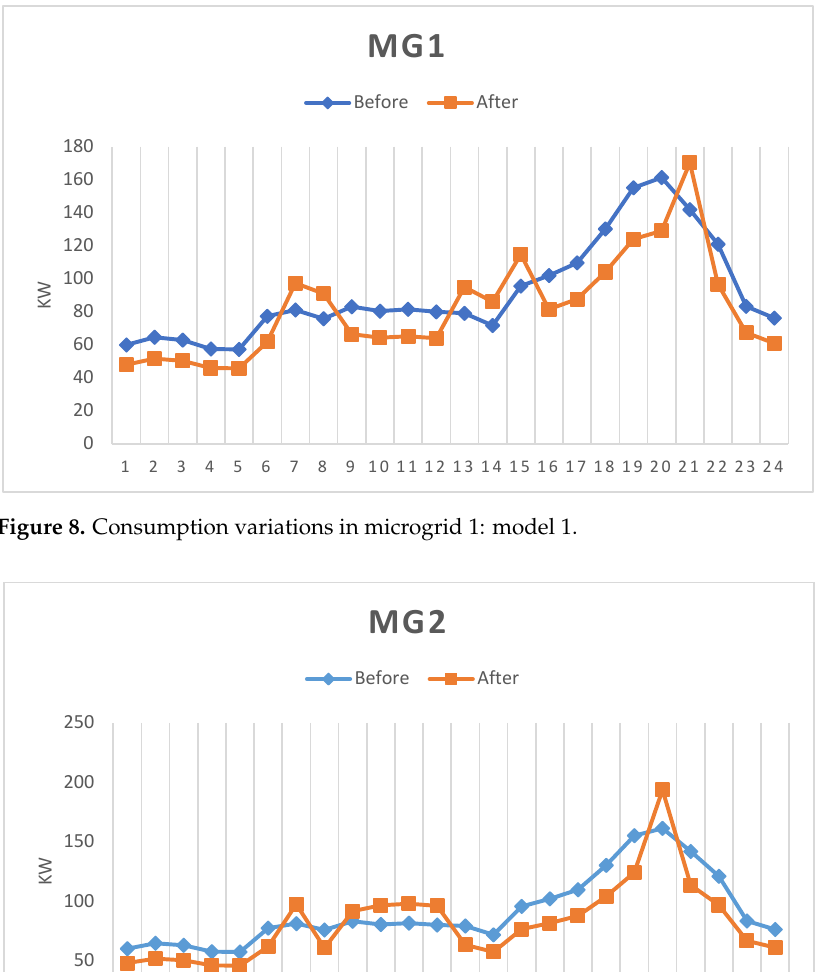
Figure 7. The basic price of buying and selling energy from each microgrid by PSO.